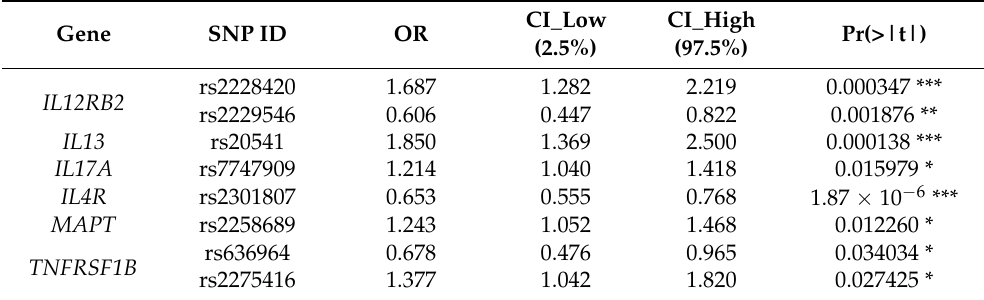
Table 4. Odds ratio calculations on multivariate analysis were applied to statistically significant variables identified by GLMM model.